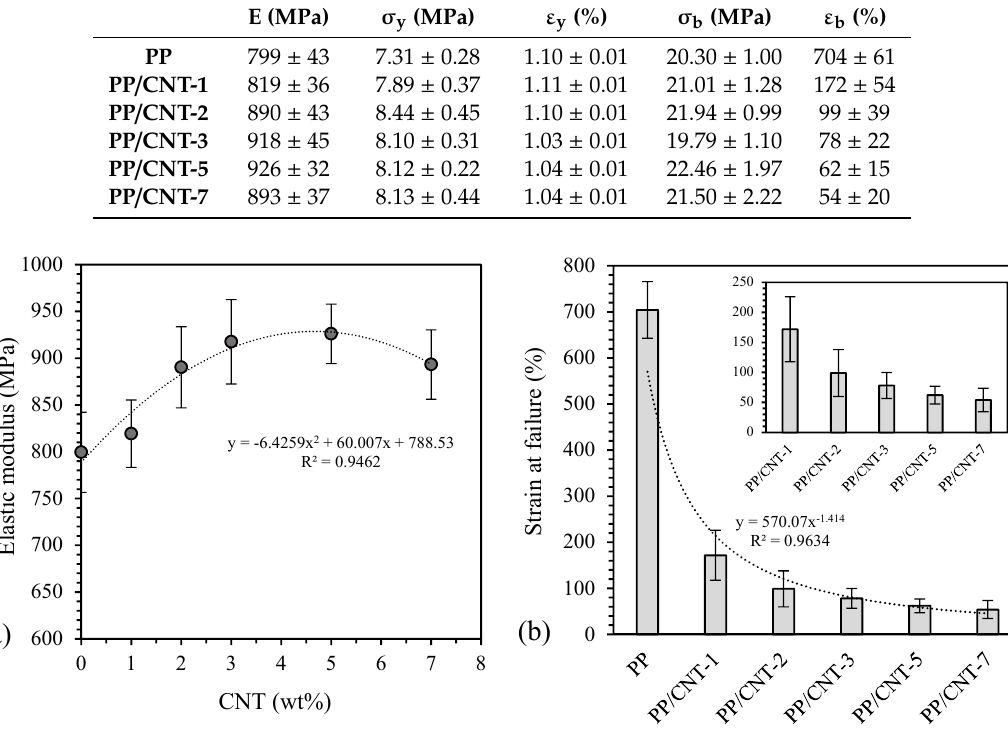
Figure 5. (a) Elastic modulus and (b) strain at failure as a function of CNTs wt% content Figure 5. ( a ) Elastic modulus and ( b ) strain at failure as a function of carbon nanotubes (CNTs) wt%